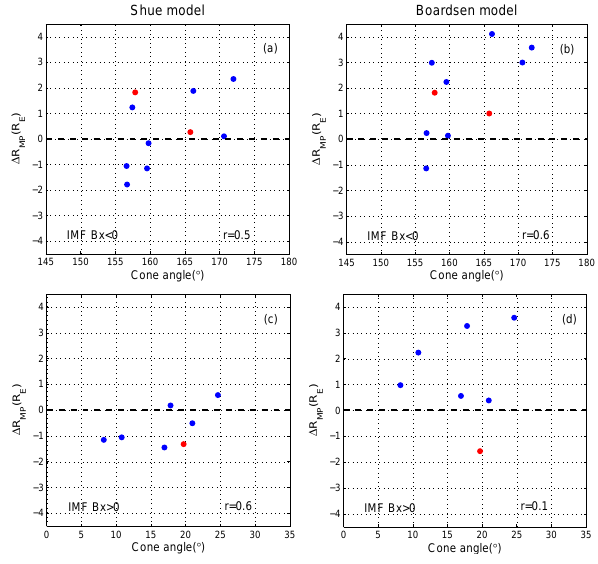
Figure 7. Same as Fig. 5 but for the IMF cone